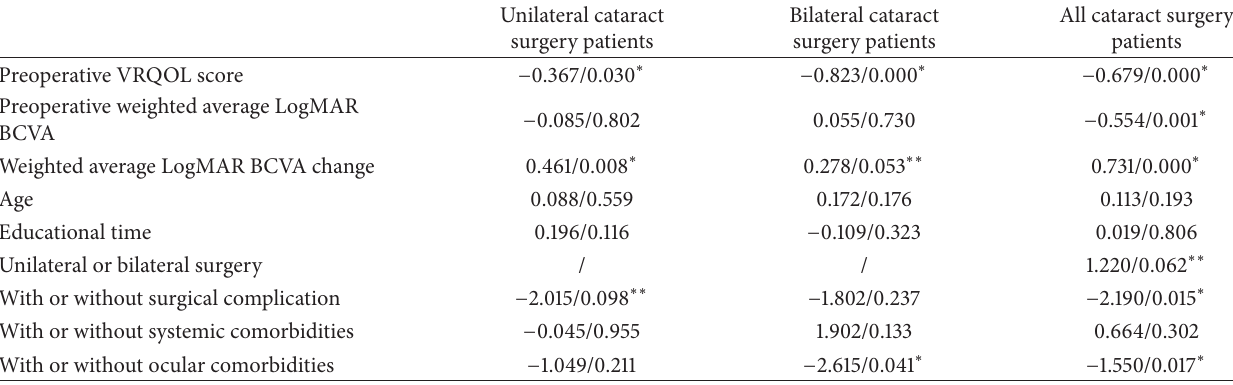
Table 5: Multiple impact factors that influence the improvement in VRQOL score at the end of the follow-up period (3 months after cataract surgery) ( ∗ 𝑃 < 0.05 , ∗∗ 0.05 < 𝑃 < 0.10